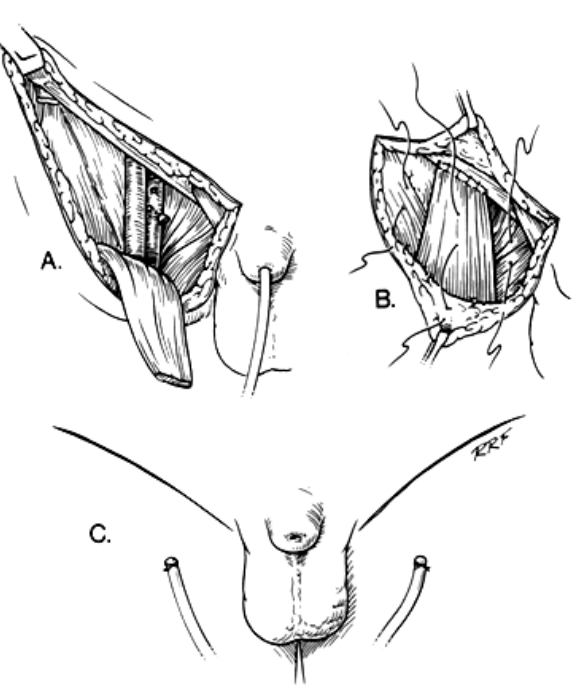
FIGURE 7 . Technique of classic inguinal lymphadenectomy. (A) View following excision of the fascia lata, division of the saphenous vein and dissection of the deep inguinal nodes. The sartorious muscle has been dissected free of its origin. (B) Transposition of the sartorious muscle to cover the femoral vessels. Mattress sutures to muscle to close potential space to void lymphocele formation. (C) Closed drainage system is place. This is maintained for 5